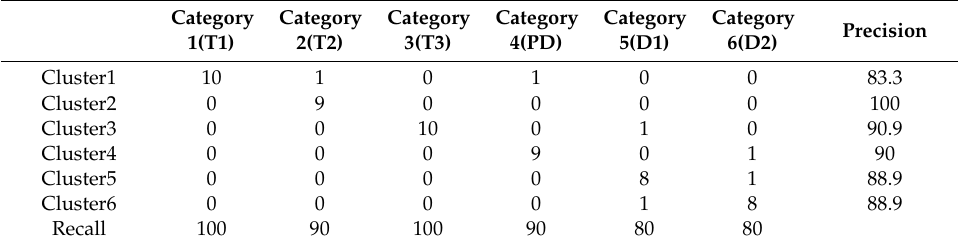
Table 5. DGA data fault type and IEC60599 diagnosis results.